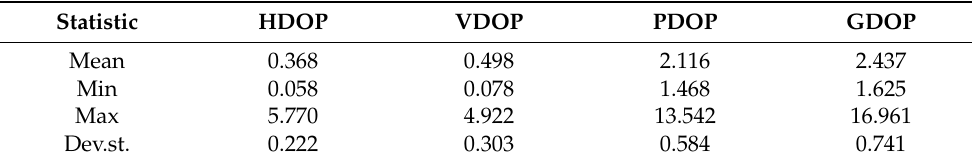
Table A2. DOP indicators of the GNSS